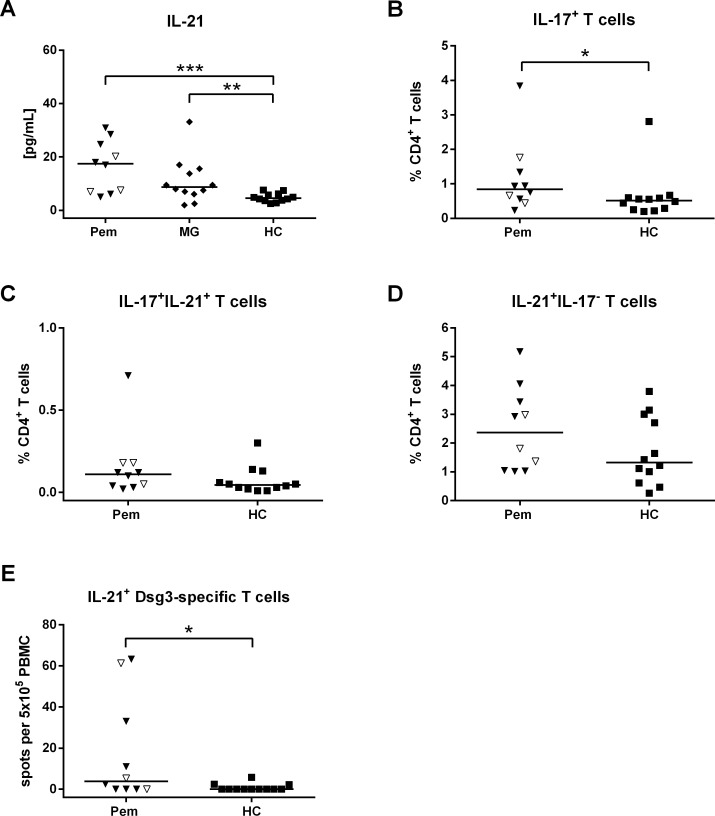
Elevated IL-21 plasma levels and increased IL-17-producing T cells in pemphigus.Patients with pemphigus (Pem; n = 10), MG (n = 12) and HC (n = 12) were analysed for IL-21 and IL-17 (A) Active Pem patients as well as MG patients displayed significantly increased plasma concentrations of IL-21. (B) An increasing frequency of IL-17-producing T cells could be obersevd in Pem patients while (C) IL-17/IL-21 double positive T cells and (D) IL-21 single positive T cells showed no statistical difference compared to HC. (E) Pem patients showed increased numbers of autoreactive IL-21-producing T cells by ELISpot assay. PBMC were used for flow cytometry analysis of the intracellular produced cytokines upon stimulation with PMA and ionomycin. Pem patients are categorized as remittent (open symbols) and active (filled symbols). Differences between the groups were analyzed using Mann-Whitney-U-Test with p values indicated as *p<0.05, **p0.01 and ***p0.001.